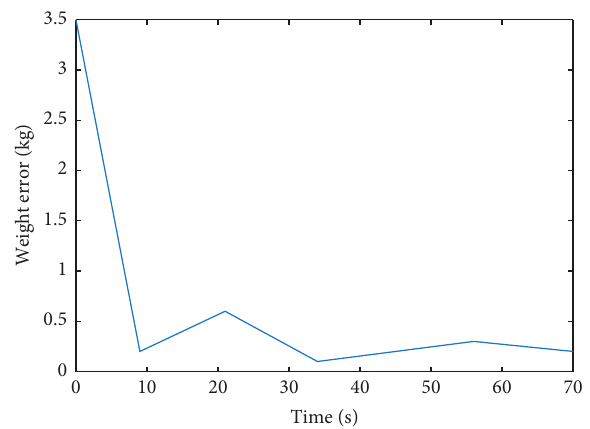
Figure 15: The weight error during working